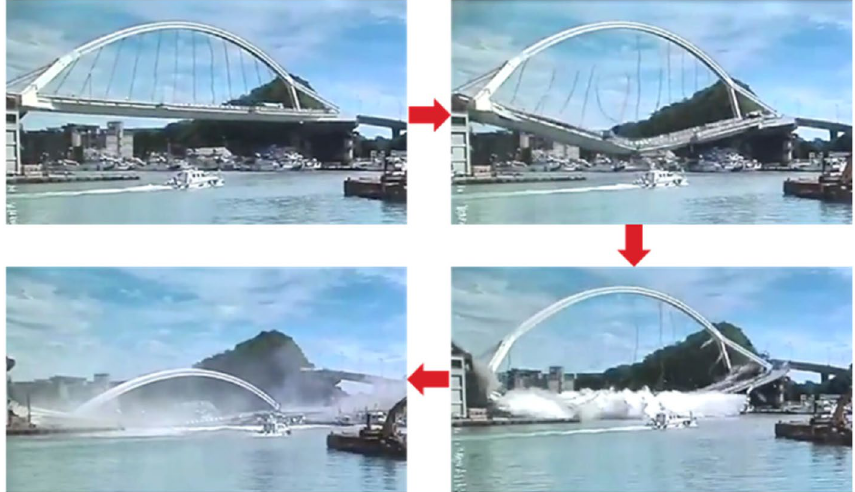
Fig. 15 The collapse processes of Taiwan Nanfang-ao cross-harbour